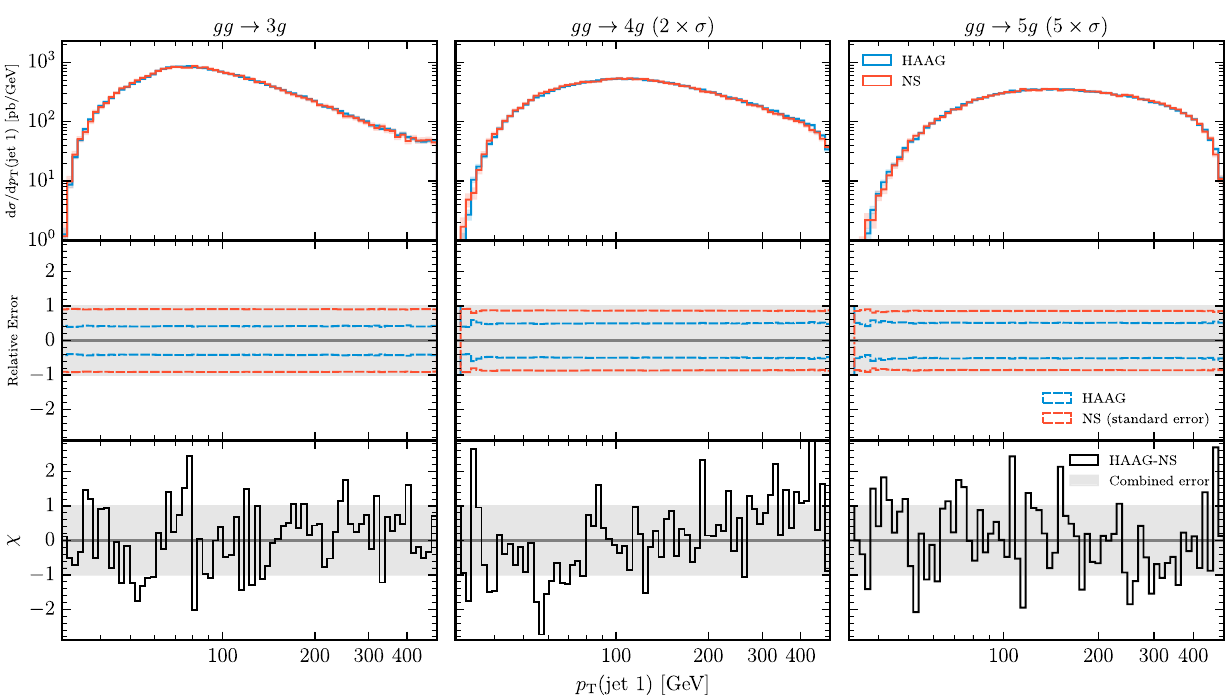
Fig. 7 The equivalent leading jet transverse momentum observable as calculated in Fig. 5a, using an exact unit weight compression of the same samples. A modified version of the default MC_JETS routine has been used to extend the p T range